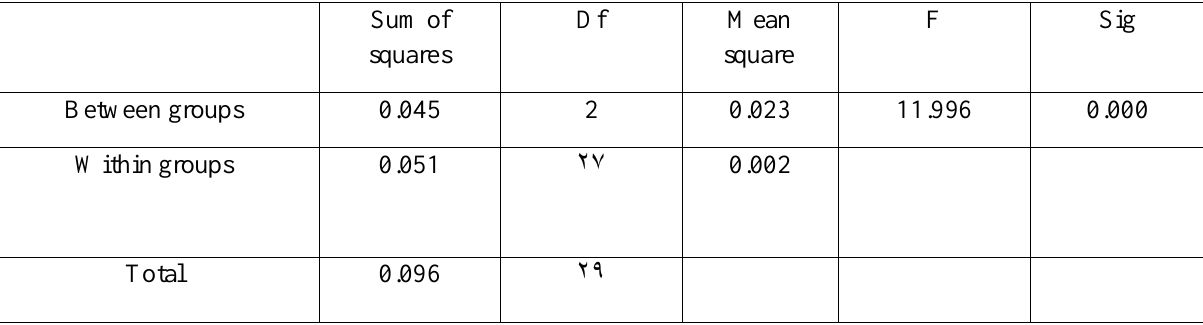
Table 4: One way ANOVA test of thermal conductivity test (W/m. ° C)